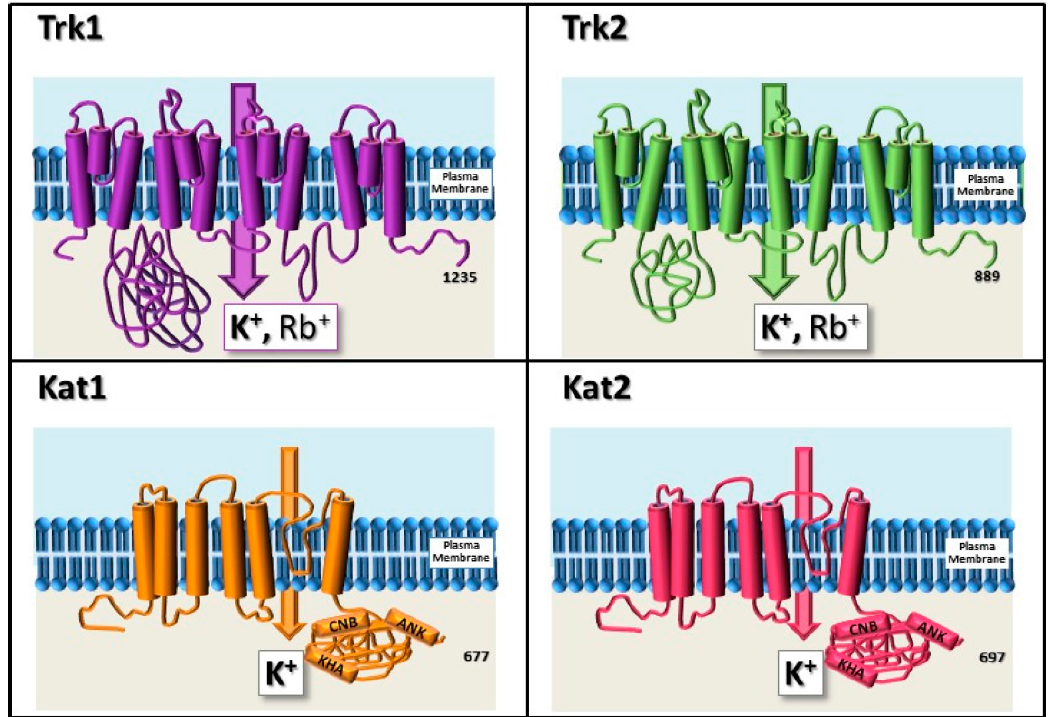
Figure 2. Schematic representation of selected K + transporter proteins from yeast and plants. Top row: Yeast Trk1 and Trk2 transporters. The 4 M1PM2 structure is depicted. Bottom row: KAT1 and KAT2 channel monomers. CNB: cyclic nucleotide binding domain; KHA: KHA domain; ANK: Ankyrin repeat.